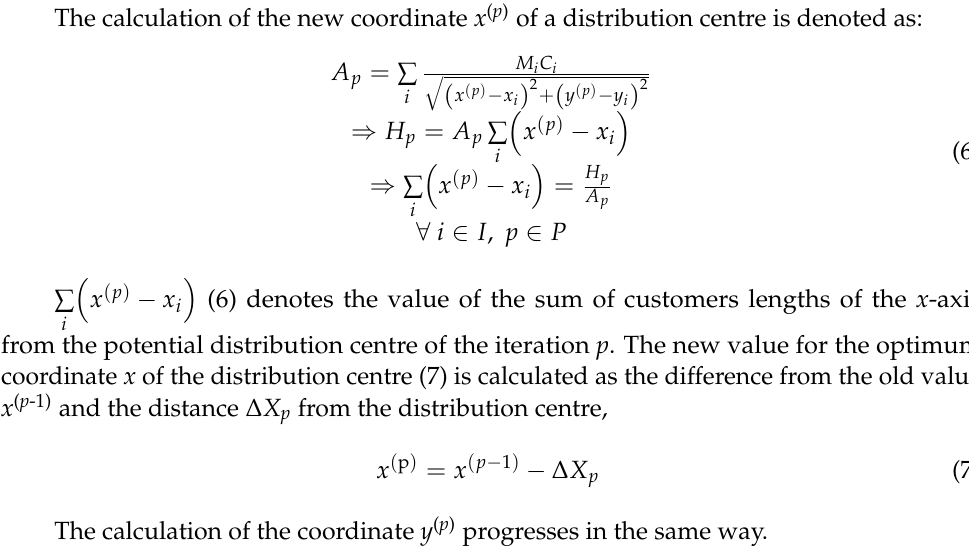
Figure 3. Calculation of the direct distance between places in the distribution